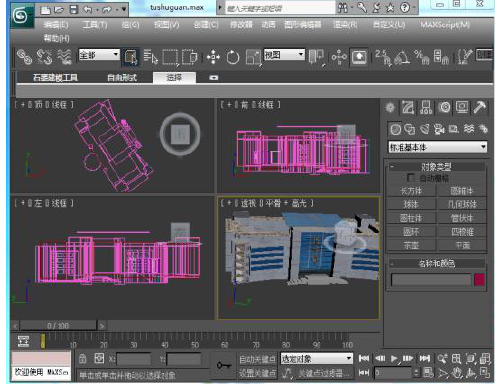
Figure 4. Modeling effect in the 3dmax